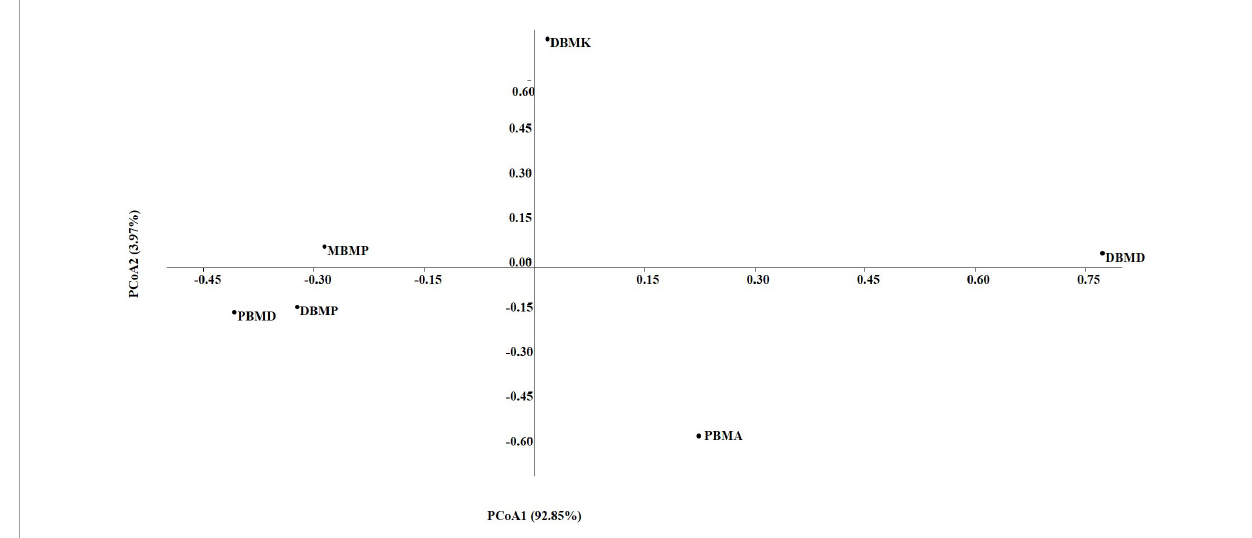
FIGURE7 PCA plot for beta diversity analysis via Bray-Curtis at the bacterial genus level.